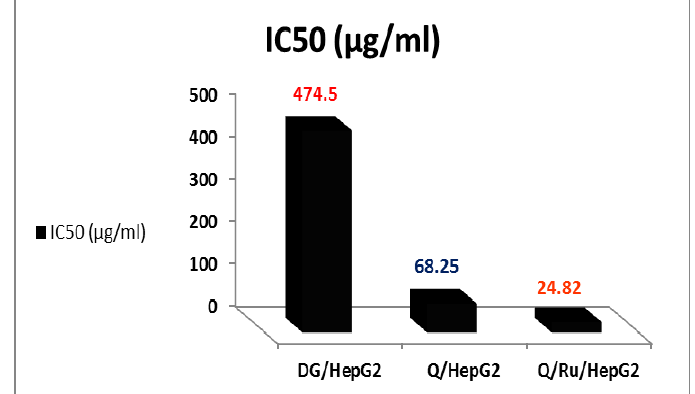
Figure 6. The IC50 of Ru III /Q, Q, and DG in HepG2 cells aging.